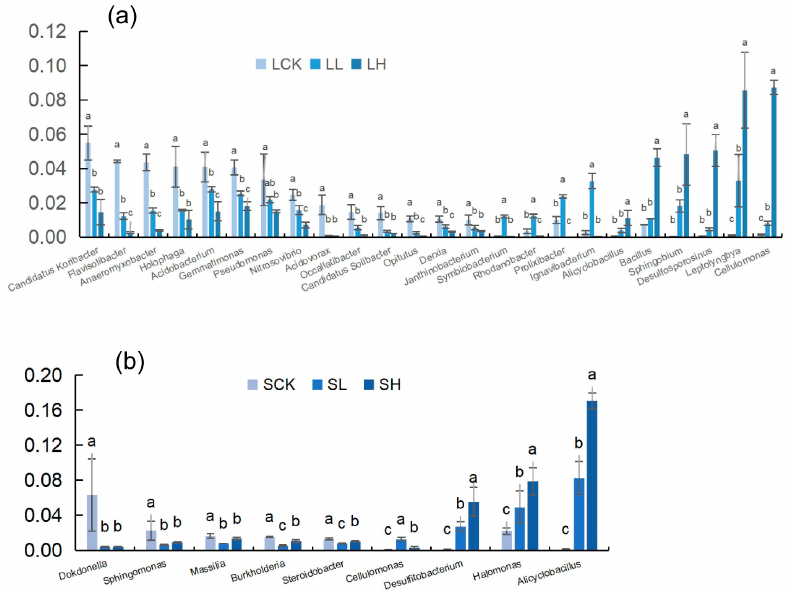
Figure 4. Changes in the relative abundances of bacterial dominant genera (relative abundance ≥ 1%) under different treatments in loamy ( a ) and sandy ( b ) soils. Different letters to show statistical significant differences by an ANOVA analysis ( p < 0.05, n = 3).